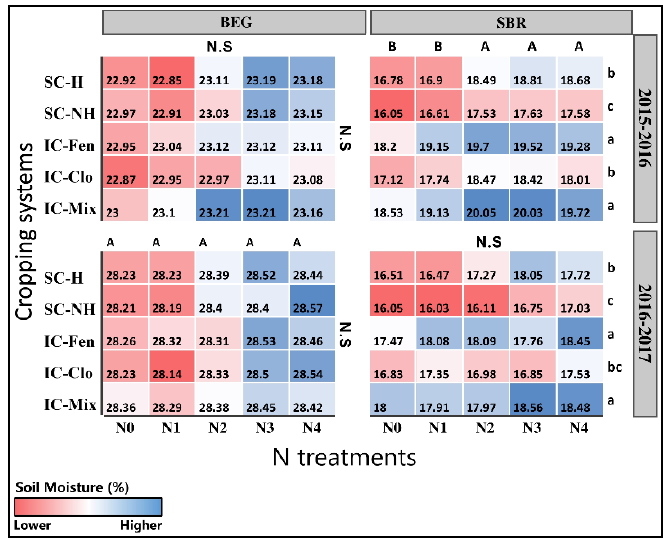
Figure 4. Effects of cropping pattern and N treatment on soil moisture at legumes flowering in 2016 and 2017 seasons, at both sites. Capital letters (A, B) indicate significant differences between N treatments (cropping patterns combined), according to Tukey’s HSD-test. Lower-case letters (a, b, c) indicate significant differences between cropping patterns (N treatments combined), according to Tukey’s HSD-test. N.S. not significant.